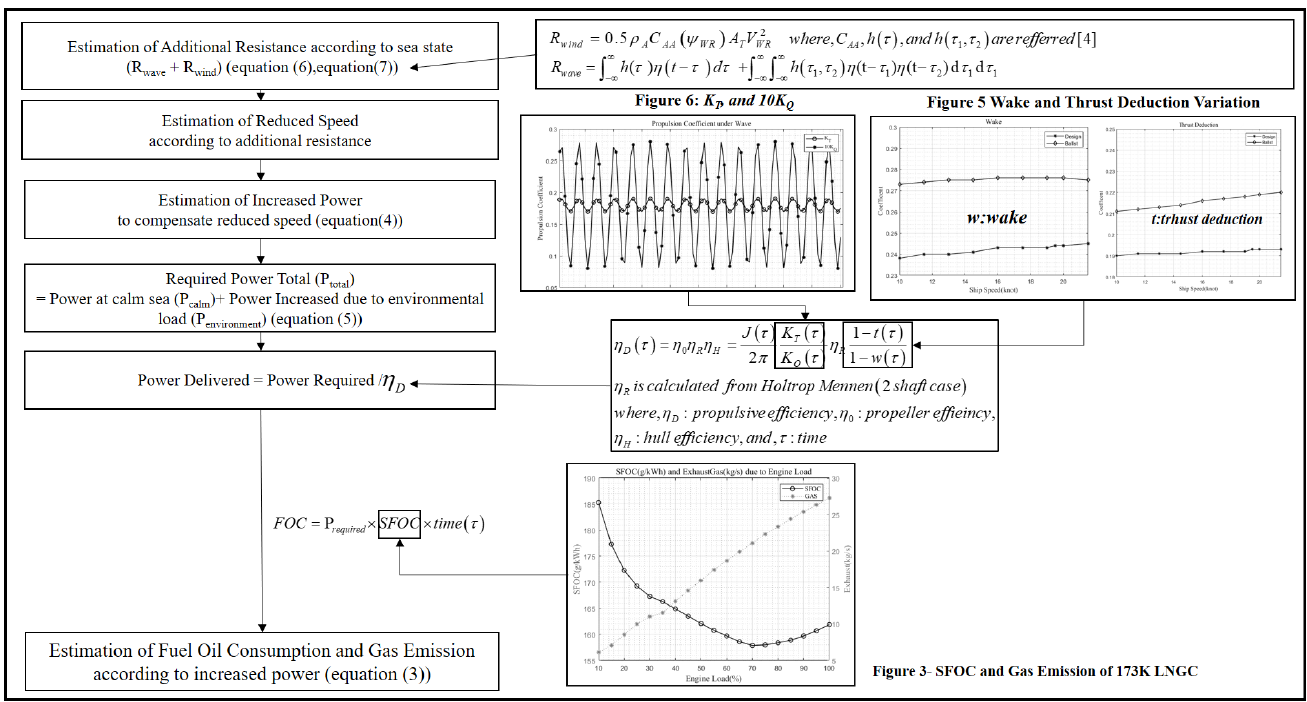
Figure 2. Fuel Oil Consumption estimation procedure (ISO 15016:2015 and Holtrop–Mennen method).